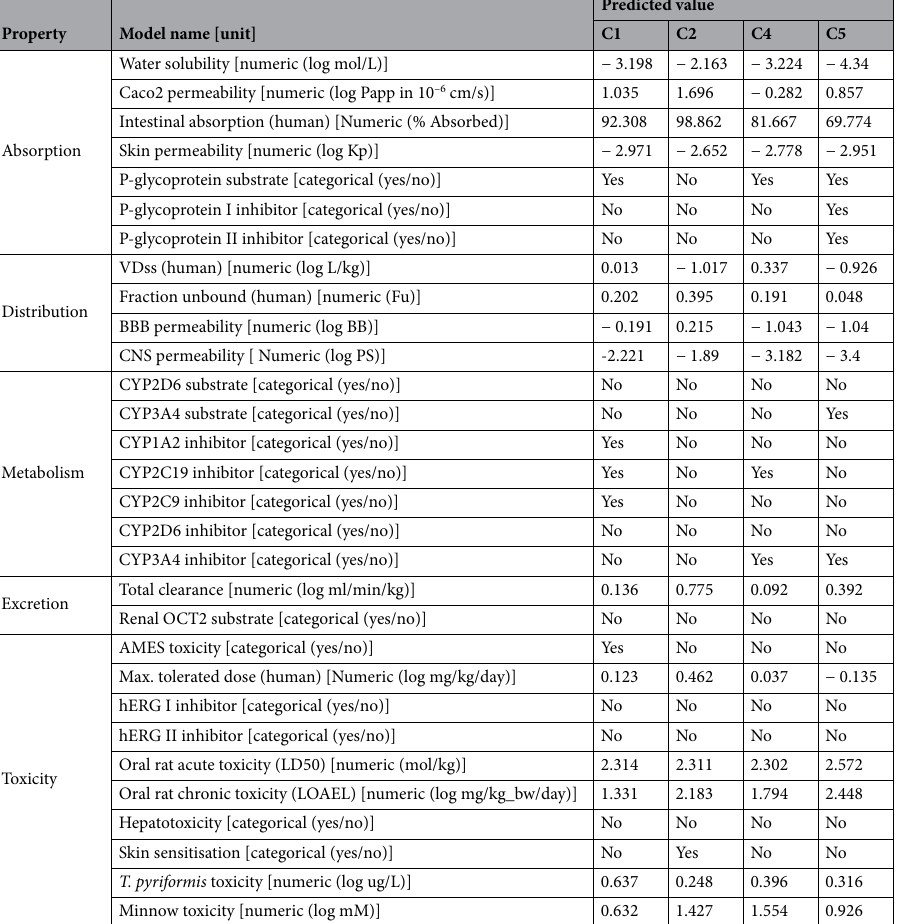
Table 3. Pharmacokinetic and toxicity properties of selected isolated